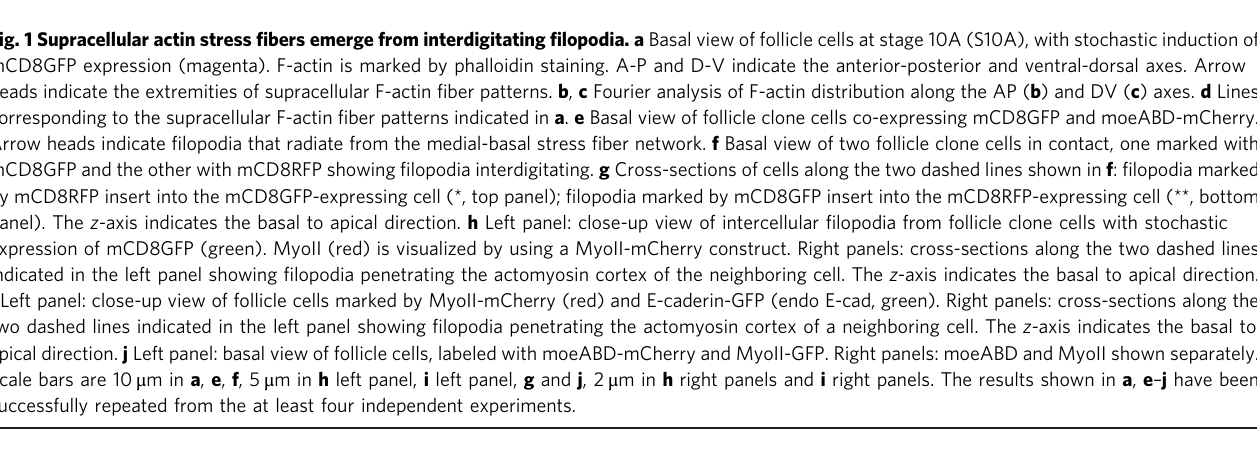
Fig. 1 Supracellular actin stress fi bers emerge from interdigitating fi lopodia. a Basal view of follicle cells at stage 10A (S10A), with stochastic induction of mCD8GFP expression (magenta). F-actin is marked by phalloidin staining. A-P and D-V indicate the anterior-posterior and ventral-dorsal axes. Arrow heads indicate the extremities of supracellular F-actin fi ber patterns. b , c Fourier analysis of F-actin distribution along the AP ( b ) and DV ( c ) axes. d Lines corresponding to the supracellular F-actin fi ber patterns indicated in a . e Basal view of follicle clone cells co-expressing mCD8GFP and moeABD-mCherry. Arrow heads indicate fi lopodia that radiate from the medial-basal stress fi ber network. f Basal view of two follicle clone cells in contact, one marked with mCD8GFP and the other with mCD8RFP showing fi lopodia interdigitating. g Cross-sections of cells along the two dashed lines shown in f : fi lopodia marked by mCD8RFP insert into the mCD8GFP-expressing cell (*, top panel); fi lopodia marked by mCD8GFP insert into the mCD8RFP-expressing cell (**, bottom panel). The z- axis indicates the basal to apical direction. h Left panel: close-up view of intercellular fi lopodia from follicle clone cells with stochastic expression of mCD8GFP (green). MyoII (red) is visualized by using a MyoII-mCherry construct. Right panels: cross-sections along the two dashed lines indicated in the left panel showing fi lopodia penetrating the actomyosin cortex of the neighboring cell. The z- axis indicates the basal to apical direction. i Left panel: close-up view of follicle cells marked by MyoII-mCherry (red) and E-caderin-GFP (endo E-cad, green). Right panels: cross-sections along the two dashed lines indicated in the left panel showing fi lopodia penetrating the actomyosin cortex of a neighboring cell. The z- axis indicates the basal to apical direction. j Left panel: basal view of follicle cells, labeled with moeABD-mCherry and MyoII-GFP. Right panels: moeABD and MyoII shown separately. Scale bars are 10 μ m in a , e , f , 5 μ m in h left panel, i left panel, g and j , 2 μ m in h right panels and i right panels. The results shown in a , e – j have been successfully repeated from the at least four independent